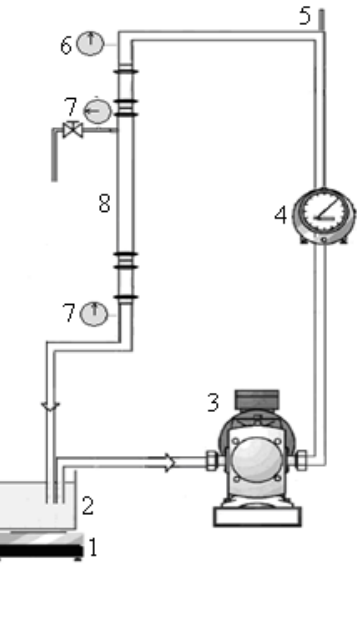
Figure 1. Scheme of crossflow filtration system, 1: Heating plate; 2: Feed tank; 3: Feed volumetric pump; 4: Flow meter; 5: Temperature gauge; 6 and 7: Pressure gauges; 8: Membrane